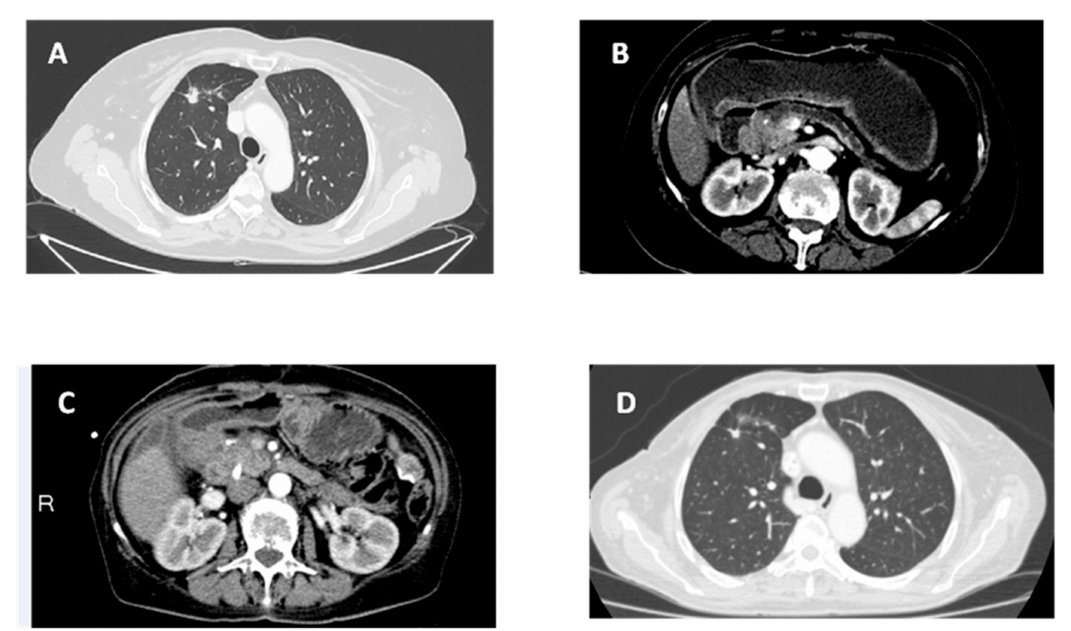
Figure 1. Radiological evaluation of patient with computerized tomography.( A ) Radiological presentation of primarylung cancer with pericardial e ff usion. ( B ) Radiological presentation of primary pancreatic cancer with bowel obstruction. ( C ) Radiological presentation of pancreatic cancer at progression. ( D ) Radiological presentation of primarylung cancer in stable disease.